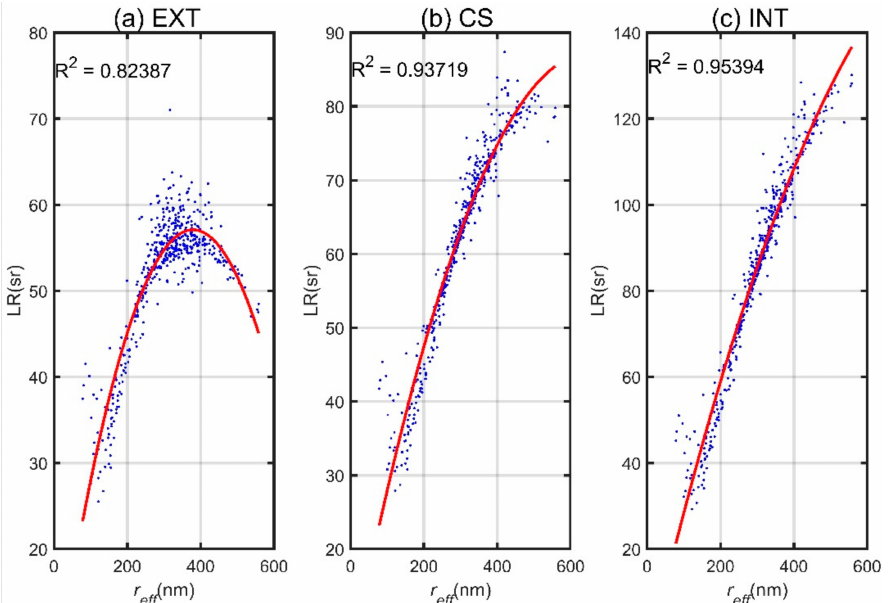
Figure 4. Regression analysis results of r ef f and LR for the ( a ) external mixing state, ( b ) core-shell mixing state, and ( c ) homogeneously internal mixing